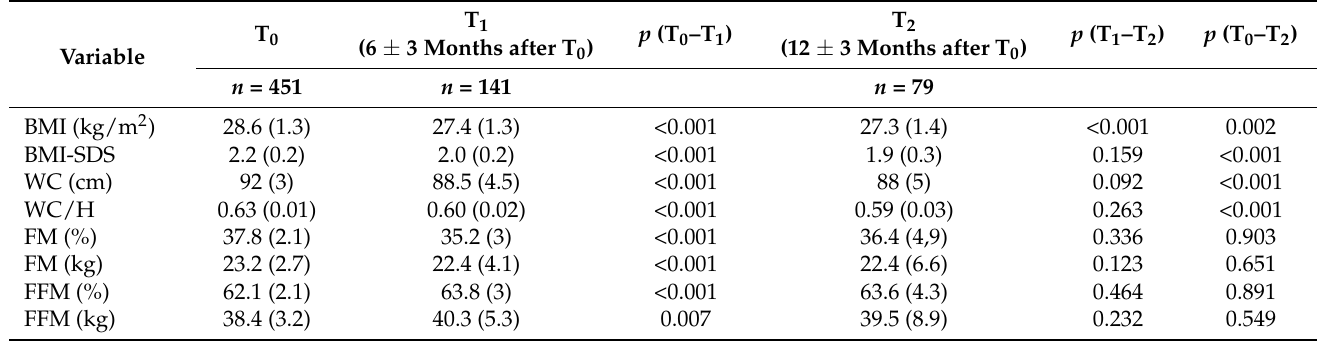
Table 2. Median values and interquartile ranges for anthropometric and body composition variables measured at baseline (T 0 ) and at first (T 1 ) and second appointment (T 2 ) in the returners’ group with corresponding p values from Wilcoxon signed rank